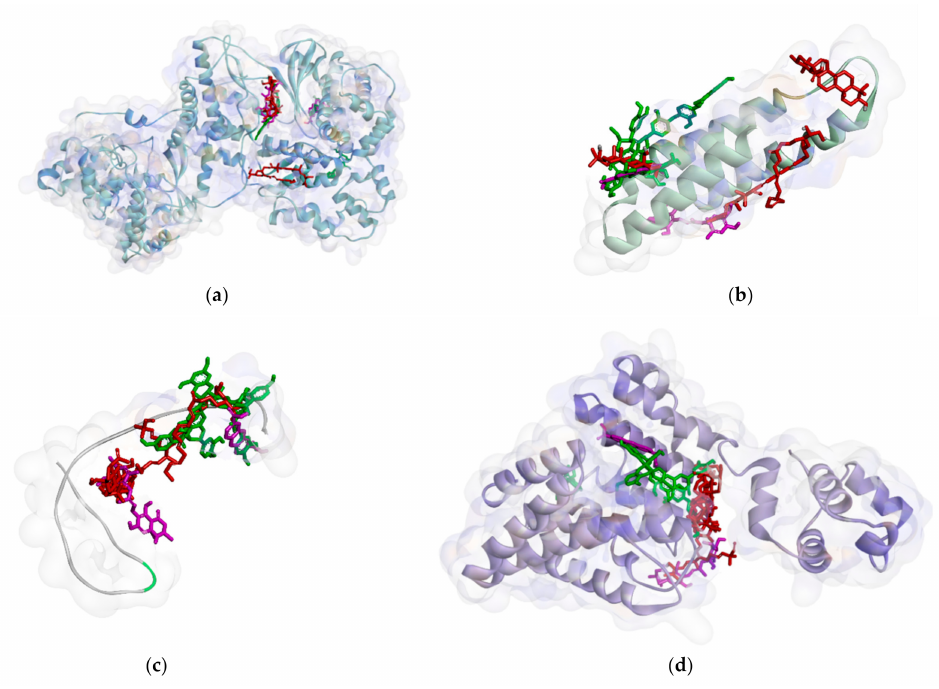
Figure 5. Ligands position in quorum sensing protein: ClyM ( a ), FsrB ( b ), GBAP ( c ), and PgrX ( d ). Furthermore, M. pendans compounds block the 50S and 30S protein subunits with different types (Figure 6). In the 50S subunit, almost all ligands get together in the same pocket, but not in the subunit 30S. Many of the same ligand-bound residues in the 50S subunit indicate that they are competitive inhibitors, while almost no bound residues indicate they are non-competitive inhibitors.